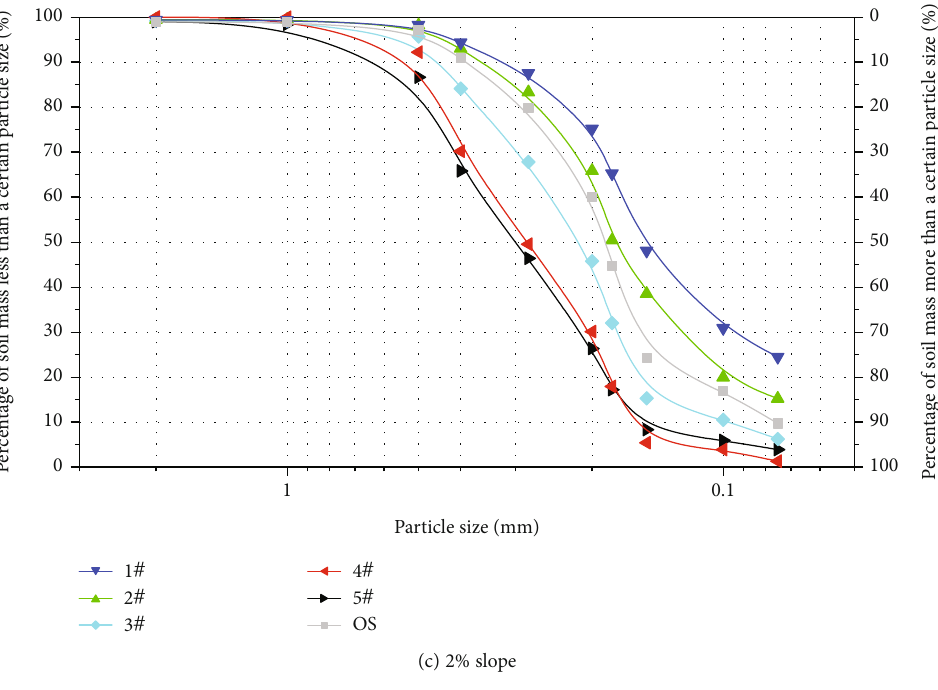
Figure 5: Cumulative curve of tailings deposition in di ff erent dry beach slopes.